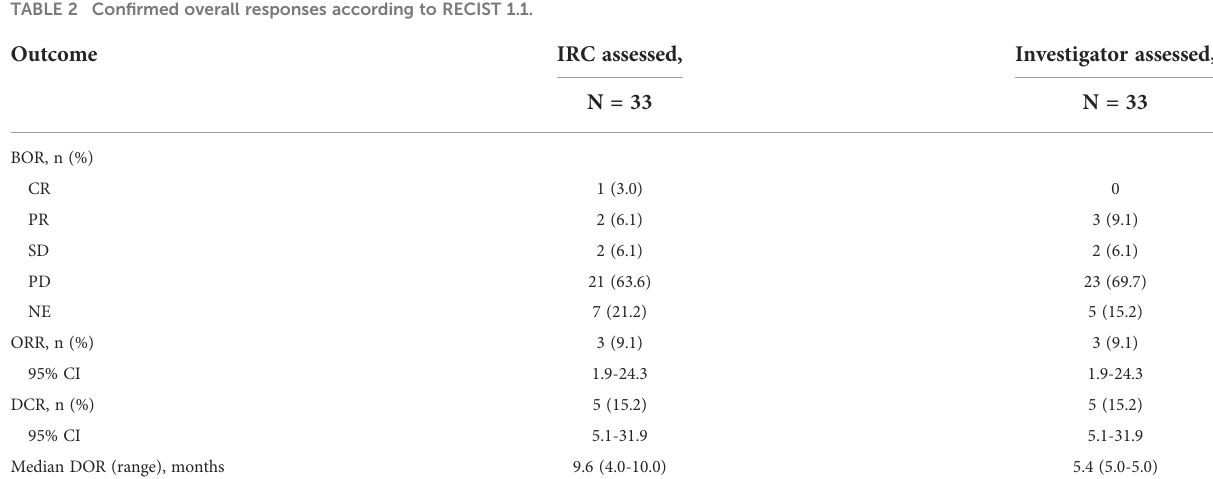
TABLE 2 Con fi rmed overall responses according to RECIST